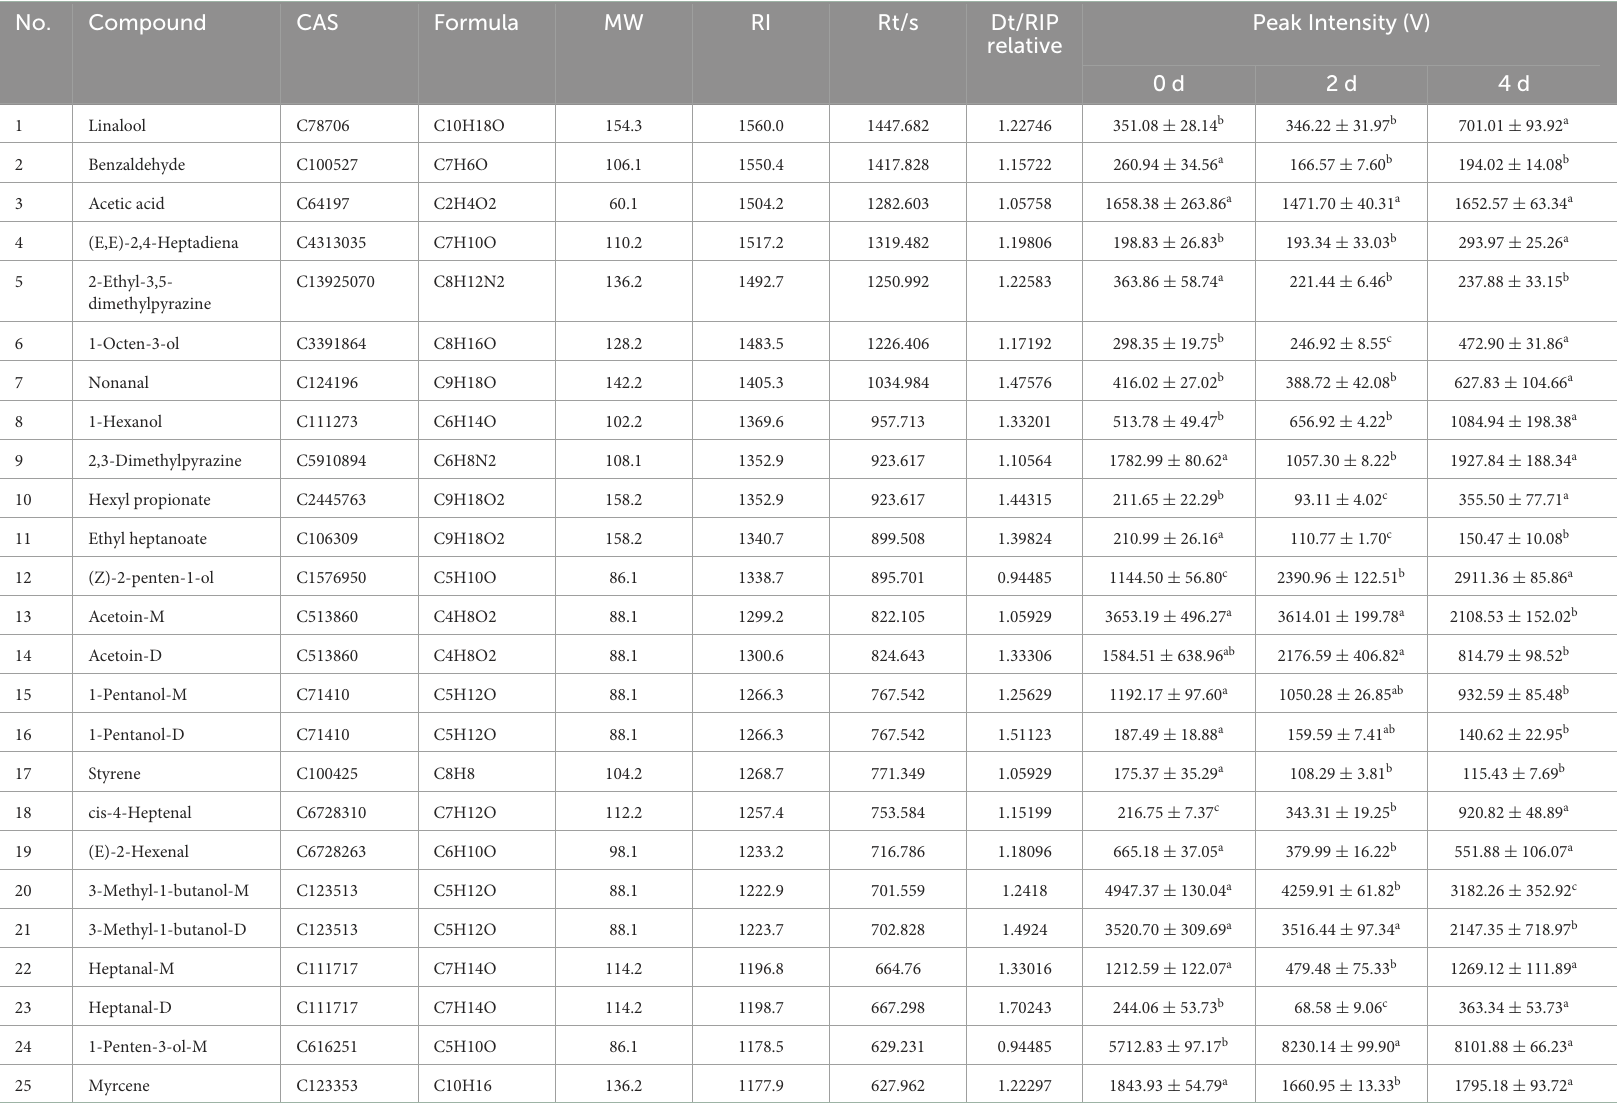
TABLE 1 Results of the qualitative analysis of volatile flavor compounds in hairtails during air-drying.